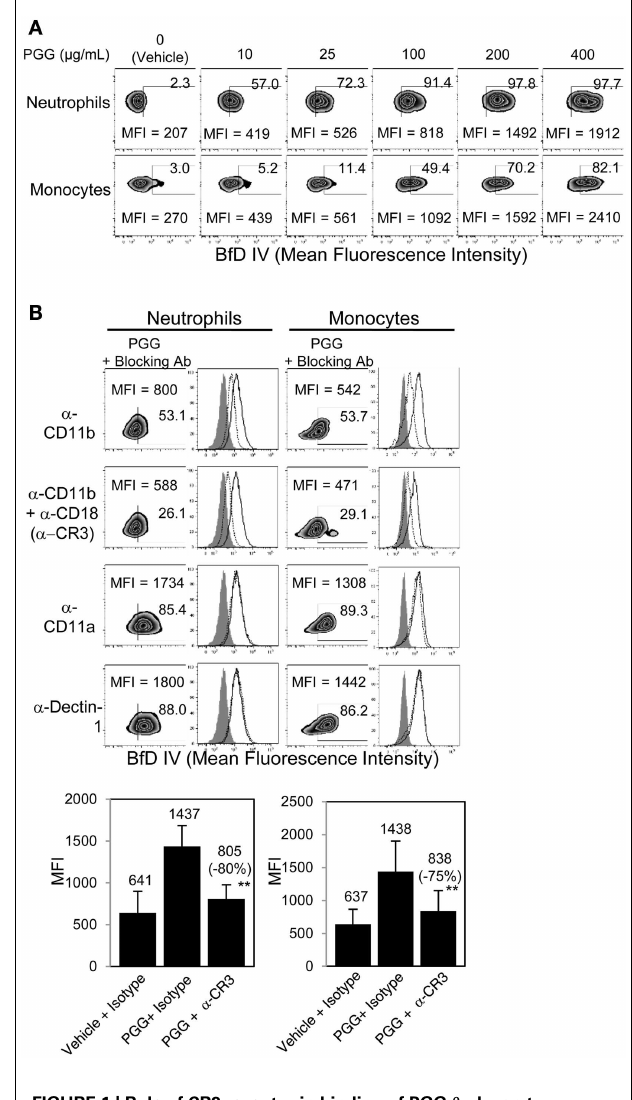
FIGURE 1 | Role of CR3 receptor in binding of PGG β -glucan to human neutrophils and monocytes . (A) Binding of increasing concentration of PGG β -glucan (0, 10, 25, 100, 200, and 400 µ g/mL) to human neutrophils (upper row) and monocytes in PBMC (lower row) was measured by flow cytometry after incubation of cells with β -glucan or vehicle at 37°C for 1h. (B) To identify the receptor involved, binding of PGG β -glucan to human neutrophils (left) and monocytes (right) was measured in the presence of α -CD11b (upper row), α -CR3 (second row), α -CD11a (third row), or α -Dectin-1 blocking antibodies (bottom row).The MFI and percentage of β -glucan-treated, BfD IV positive cells are indicated in the zebra plots. Histograms show PGG β -glucan binding in the presence of isotype controls (solid) and blocking antibodies (dotted) compared to vehicle-control binding (gray filled). Bars represent the mean MFI of the vehicle- or PGG β -glucan-treated groups in the presence of CR3 blocking or isotype control antibodies from five donors.The percentage of inhibition (in parentheses) was indicated on the graph. ** p ≤ 0.05 compared to β -glucan-treated group in the presence of isotype controls. Data shown are representative of at least three independent experiments performed with cells from different